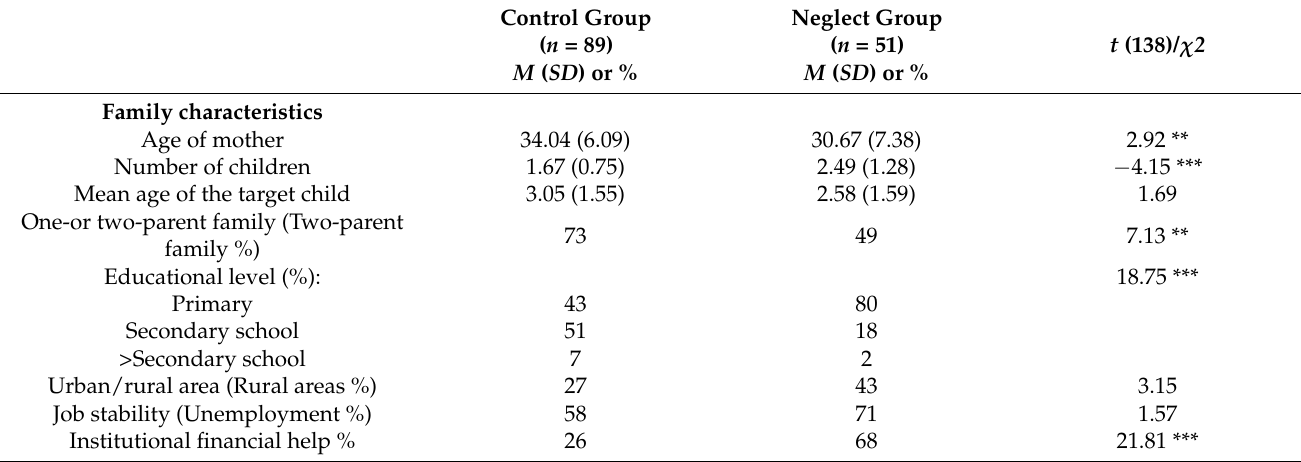
Table 1. Demographic characteristics, and study variables showing differences between the control and neglect